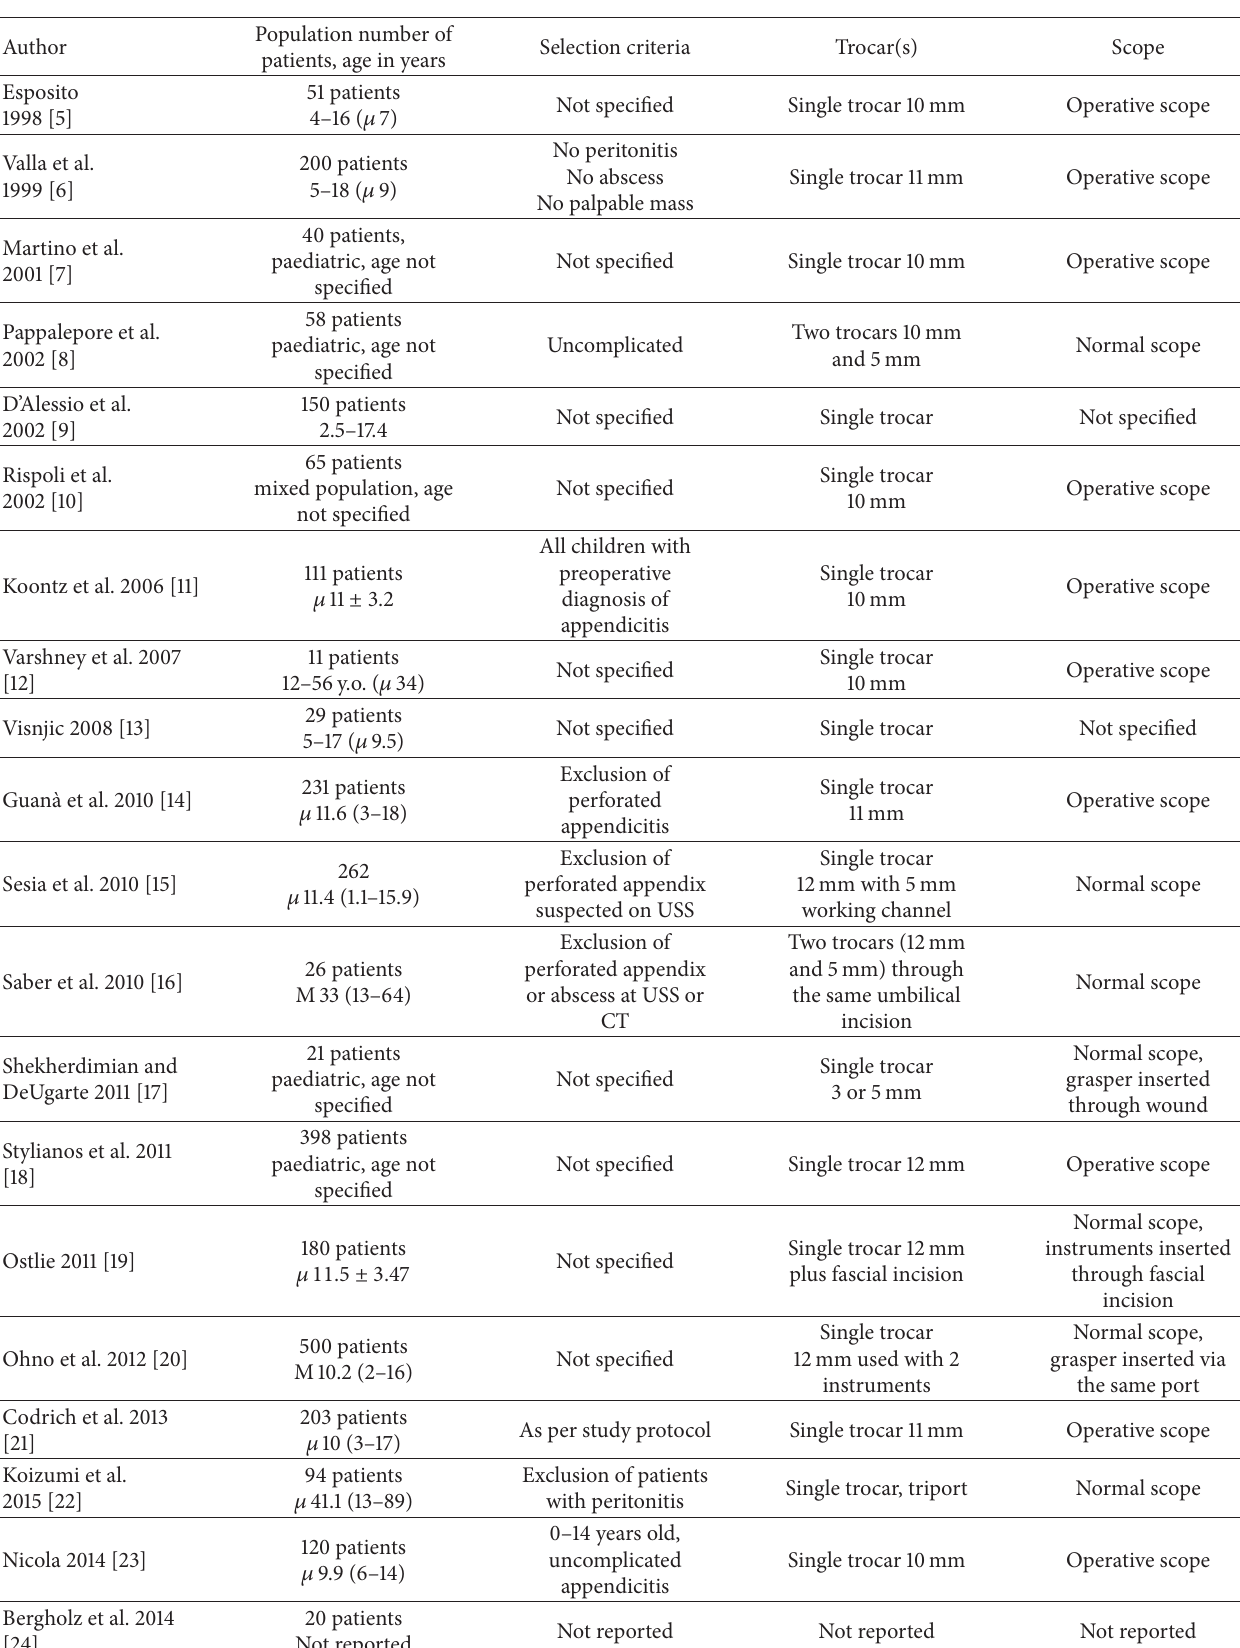
Table 1: Summary of the analysed literature including population, inclusion/exclusion criteria, and trocars and scopes